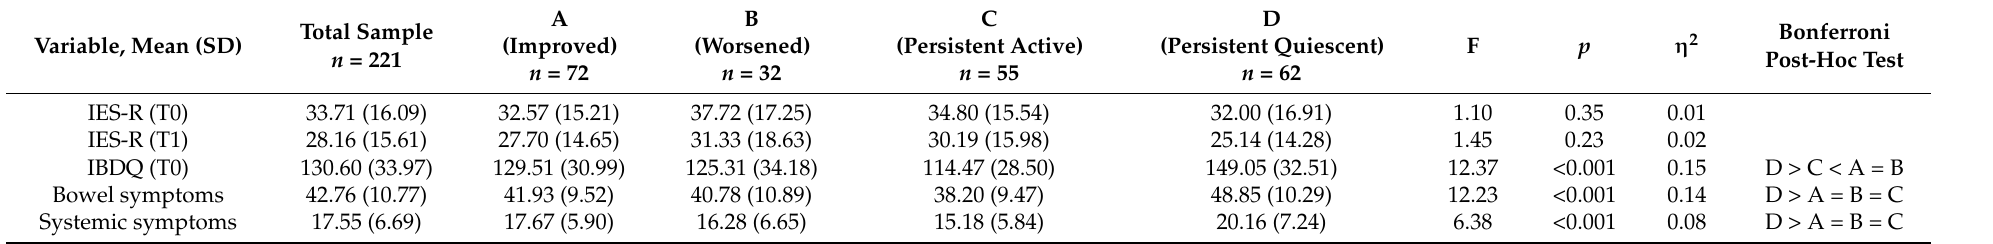
Table 3. Clinical characteristics of the total sample and the disease activity change-related